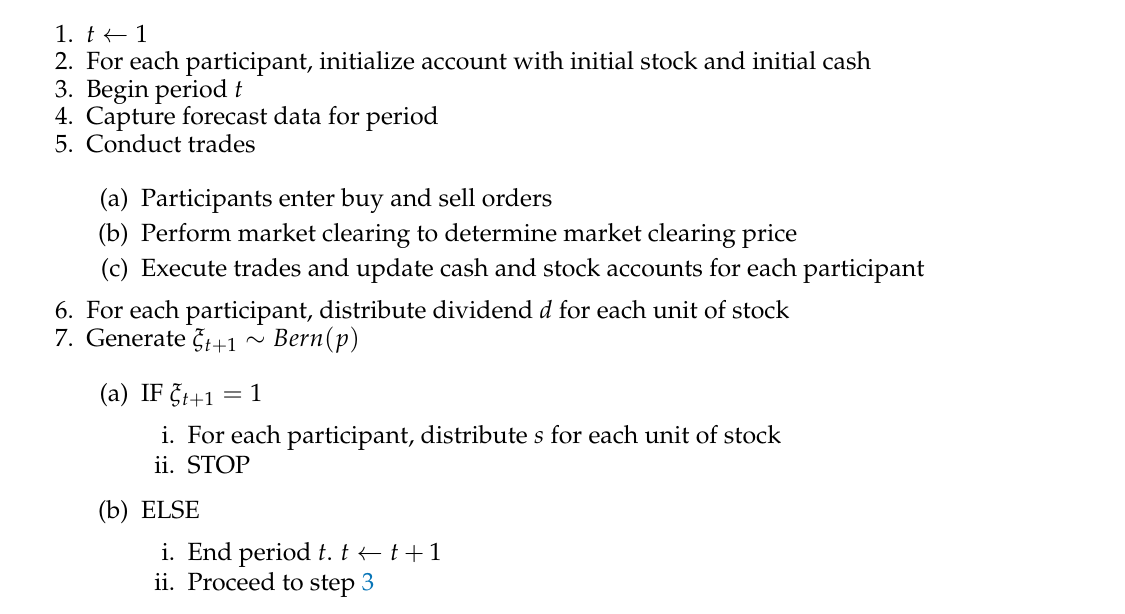
Algorithm A1 Market Algorithm with Deterministic Constant